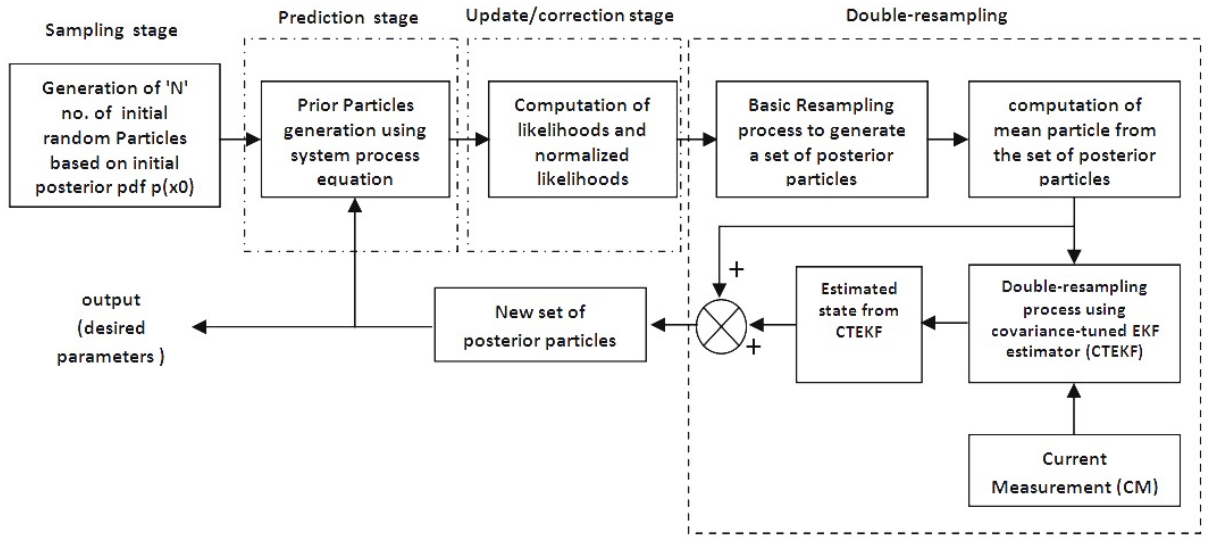
Fig. 1. The structure of the proposed CTEKF-PF